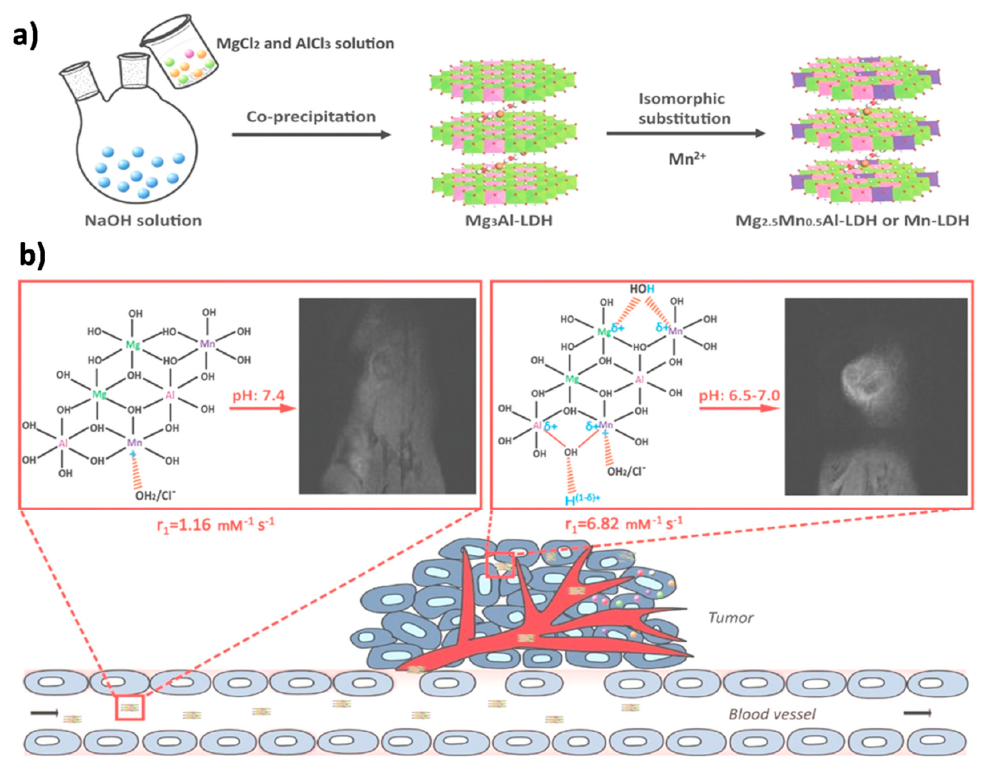
Figure 15. ( a ) Scheme of the Mg 2.5 Mn 0.5 Al LDH (Mn ‐ LDH) from co ‐ precipitation and